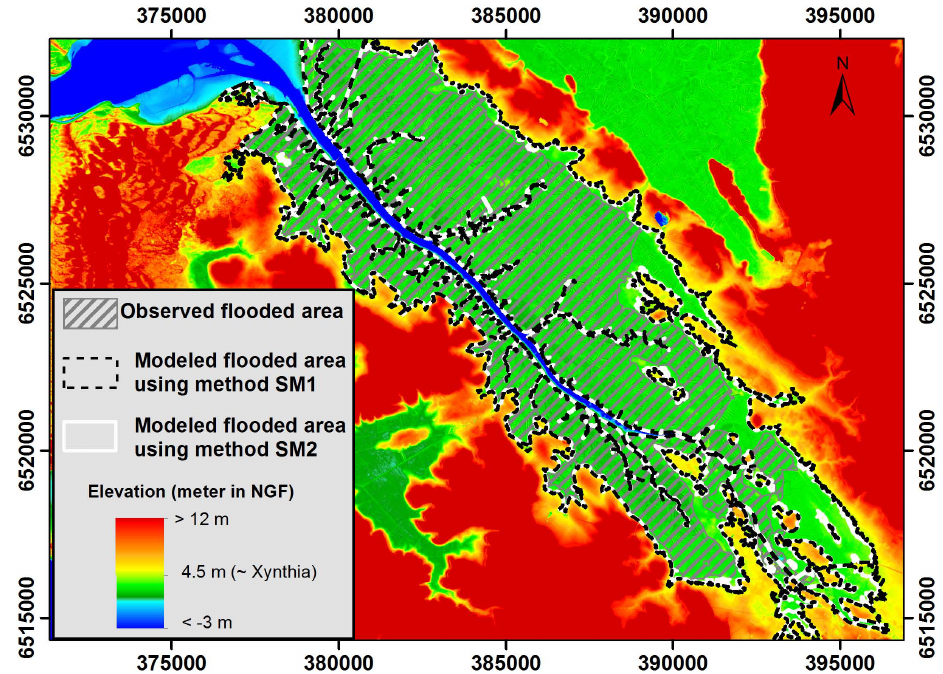
Fig. 6. Digital Terrain Model (DTM) of the Seudre Estuary Marsh (no. 25) showing the observed flooded area (hatched grey lines), the modeled flooded area using method SM1 (black dotted line) and the modeled flooded area using method SM2 (white line).